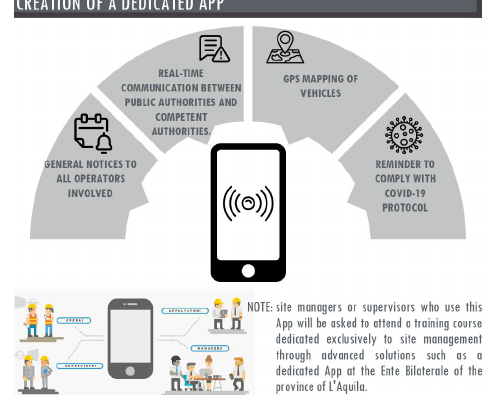
Figure 11. Dedicated App diagram. The figure illustrates